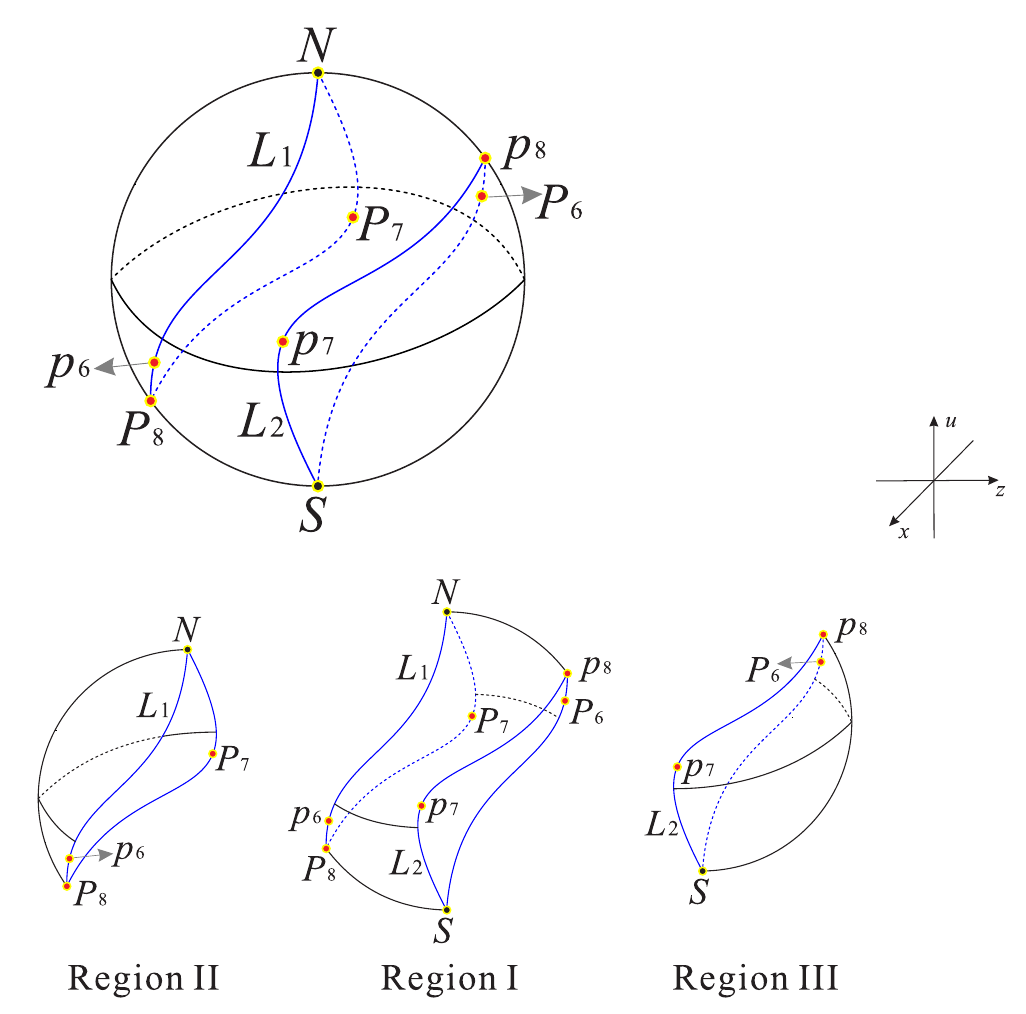
Figure 13. The sphere S 2 (the infinity of R 3 ) is filled up with equilibrium points. The stable and unstable manifolds of these equilibrium points are different in regions I, II and III; lines L 1 and L 2 ; and points p 6 , p 7 , p 8 , P 6 , P 7 and P 8 on the sphere defined by the closure of U 1 and its symmetric closure of V 1 with respect to the origin of R 3 . Thus, P 6 , P 7 and P 8 are the symmetric points with respect to the origins of p 6 , p 7 and p 8 , respectively. The points N and S denote the north pole and south pole of the Poincaré ball,